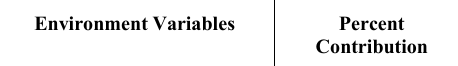
Table 2. Key Variables along with its percent contribution